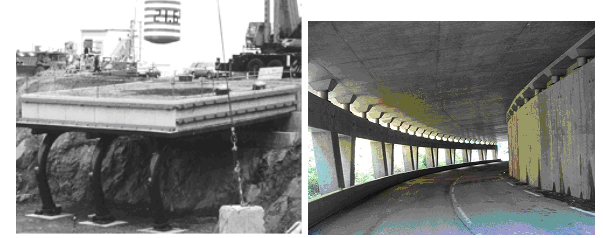
Fig. 13. Steel-concrete composite structure for a rockfall protection gallery (Konno et al., 2008)